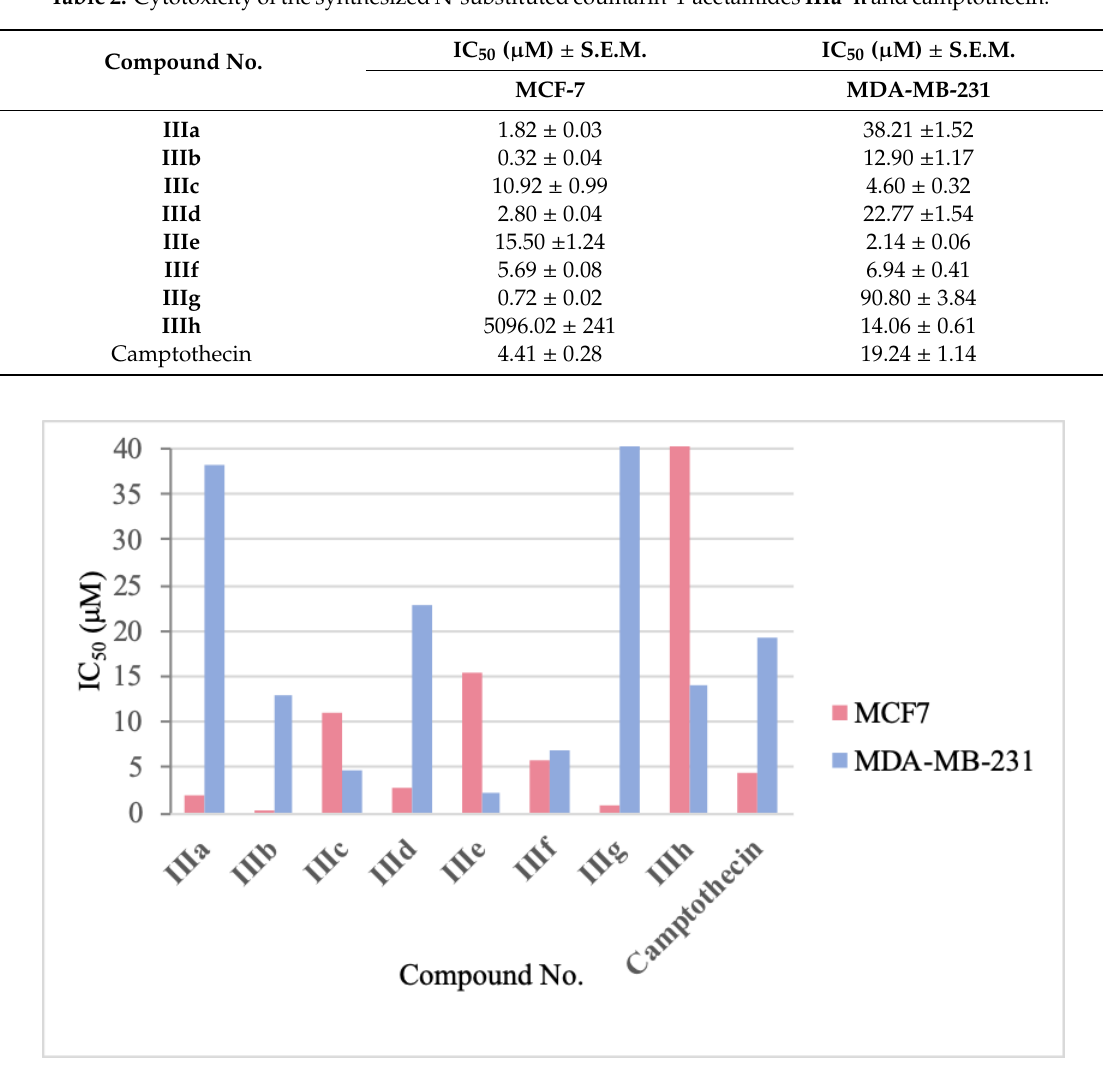
Figure 3. Cytotoxicity of N -substituted coumarin-4-acetamides IIIa – h and camptothecin.